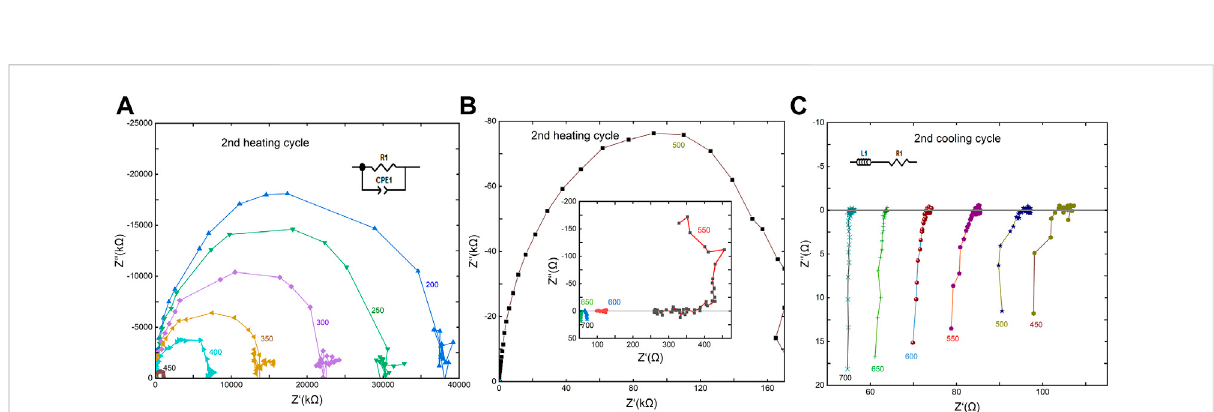
FIGURE 5 Representative complex impedance spectra measured at the second heating and cooling cycles at 2 GPa. The numbers alongside the impedance arcs are the temperature ( ° C). Impedance spectra gradually change from nearly semi arcs (A) to lines (B) with increasing temperature, re fl ecting the occurrence of sample decarbonation. In the second cooling cycle (C) , the vertical lines are across the real impedance line at all temperaturepointsthat arecharacteristicofaconductor, thustheequivalent circuitcomposed ofaninductor andresistorisusedto modelthe resistance of